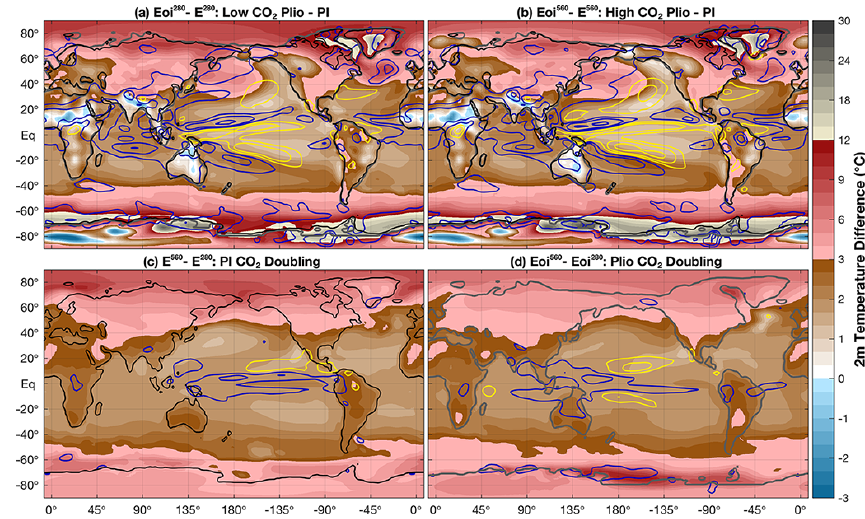
Figure 10. Annual mean near-surface air temperature difference between our four sensitivity simulations: (a) Eoi 280 − E 280 , (b) Eoi 560 − E 560 , (c) E 560 − E 280 , and (d) Eoi 560 − Eoi 280 . Contours show the difference in mean annual precipitation at 100, 200, and 500mm, with blue indicating a positive value and yellow indicating a negative